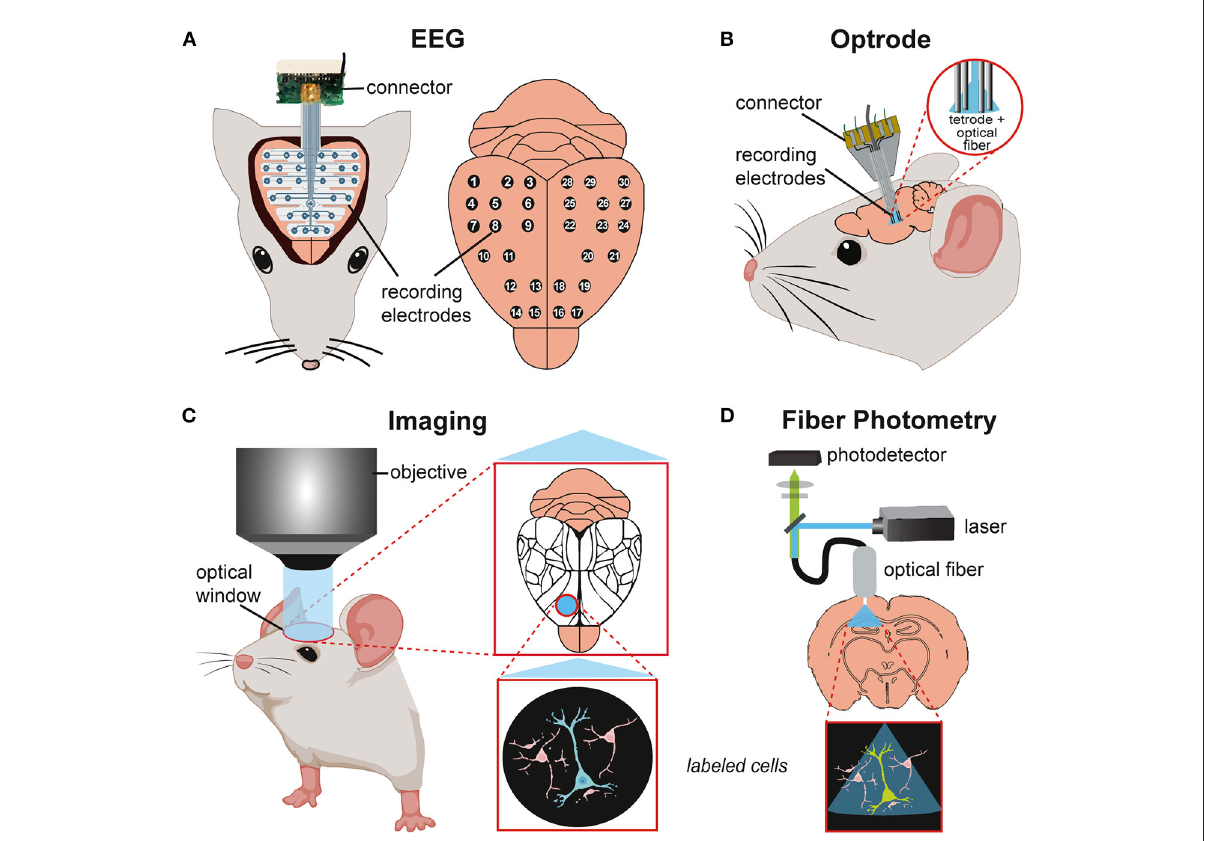
FIGURE4 Schematics of in vivo techniques for studying neuronal activity in mouse models. (A) Electroencephalography (EEG) recording with implanted EEG probe and recording electrodes (30 channels) on the brain surface. (B) Implated optrode with integration of optical fiber and recording electrodes for simultaneous optical stimulation and electrophysiological recordings. (C) Imaging of the mouse brain through an optical window for visualizing brain areas (mapping, Allen Brain Atlas) or/and single-cell activity in the region of interest. (D) Fiber photometry of a target brain region with simultaneous optical stimulation (laser) and calcium imaging (photodetector) via an implanted fiber probe.